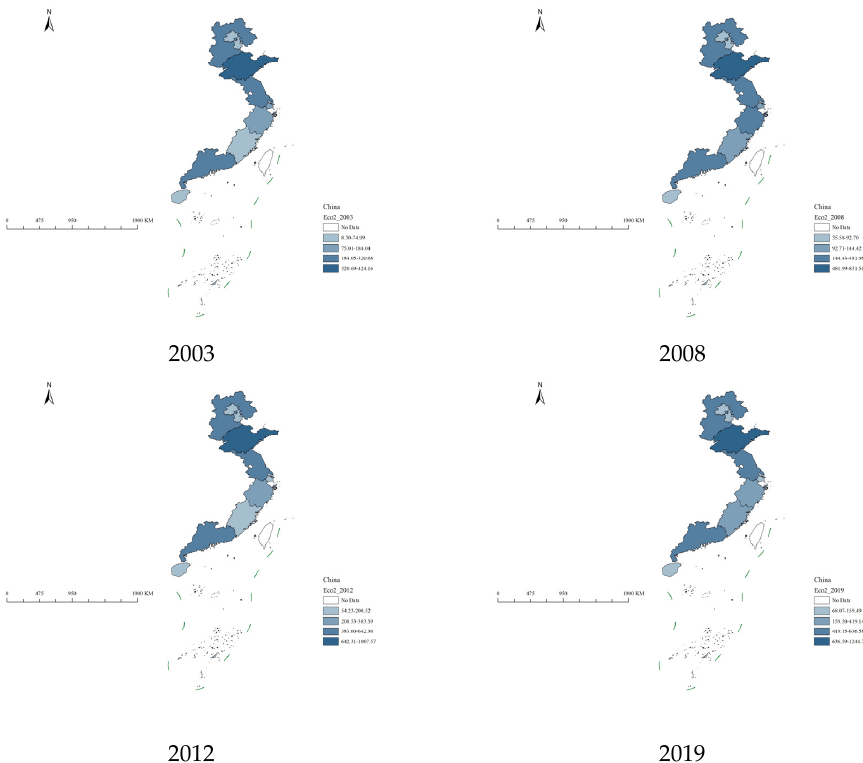
Figure 7. The trend of carbon emission levels in eastern China.